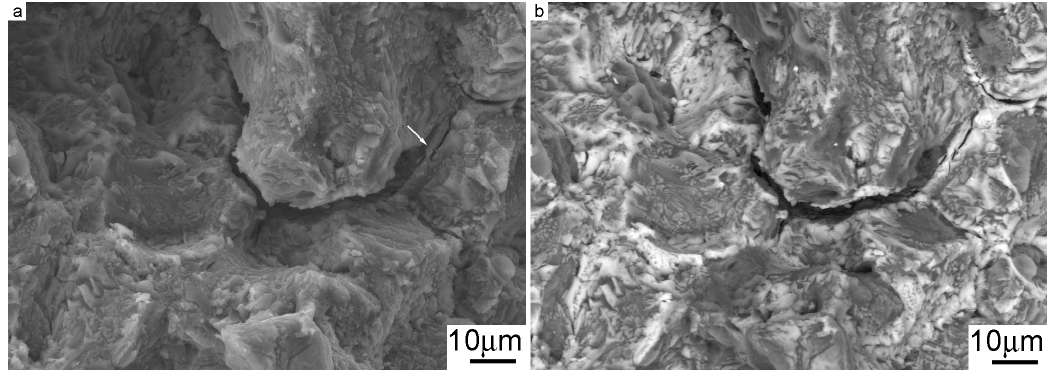
Figure 6. Scanning electron micrograph of the alloy fracture surface after the tensile test ( a ) the same location taken in BSE mode ( b ).